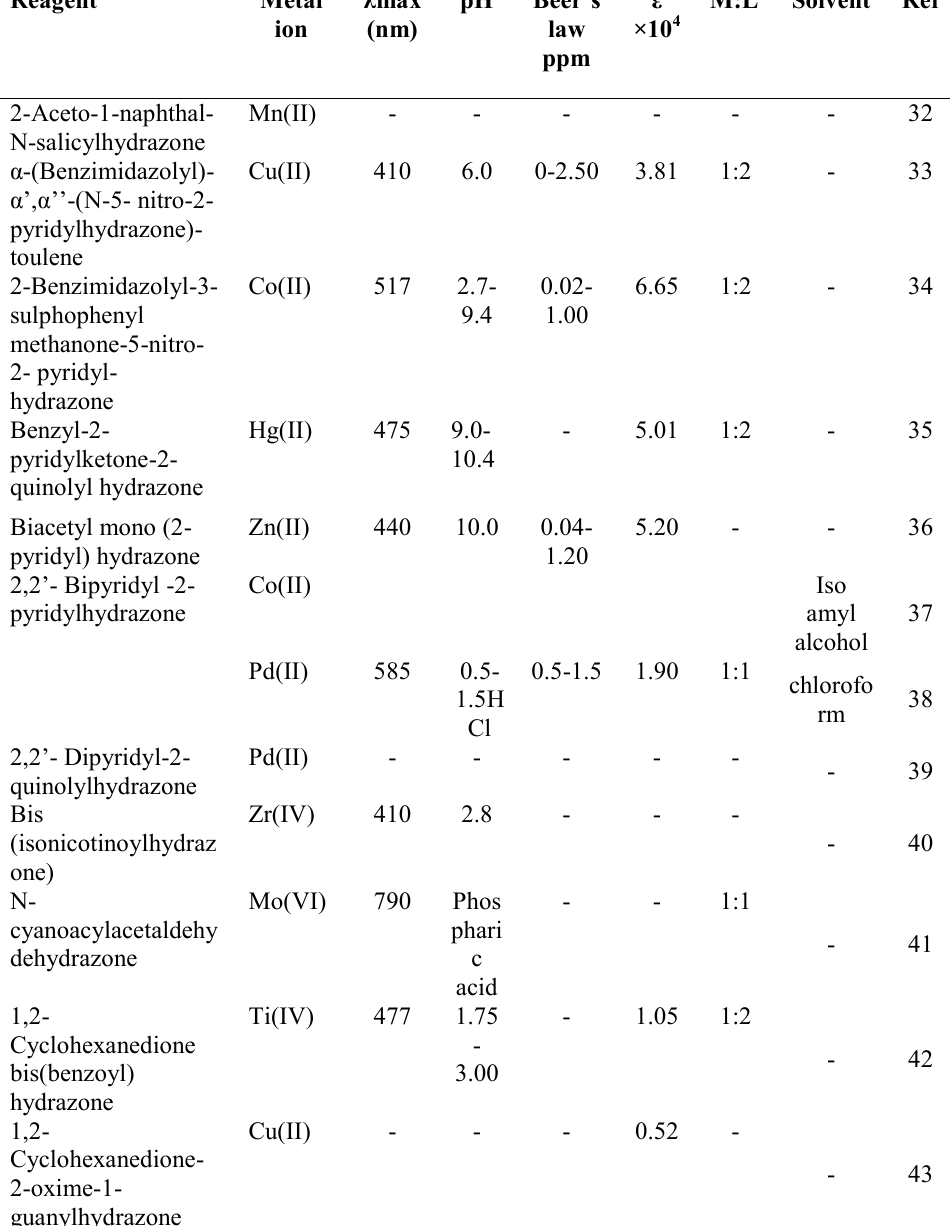
Table 1 . Analytical applications of Hydrazones in the determination of metal ions by using